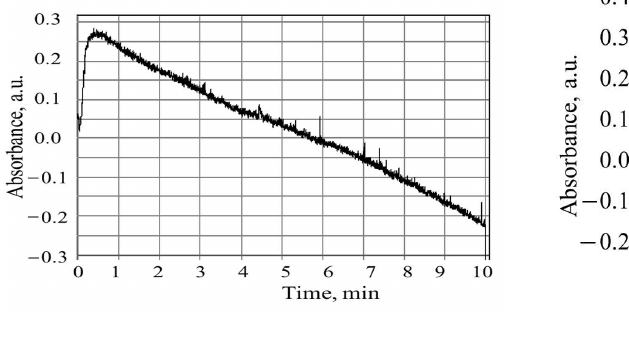
Figure 9. Electropherograms of the LF ( a ) and the mixture of LETI-11 and LF at molar proportion of 1:1 ( b ). The conditions are as in Figure 8. Zone 2 (free LETI-11); zone 3 (complex of LETI-11 and LF). Capillary pretreatment type A.